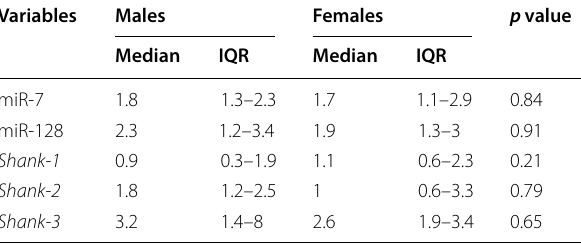
Table 6 Comparison between the expression of miRNA‑7, miRNA‑128 and SHANK family genes regarding the family history